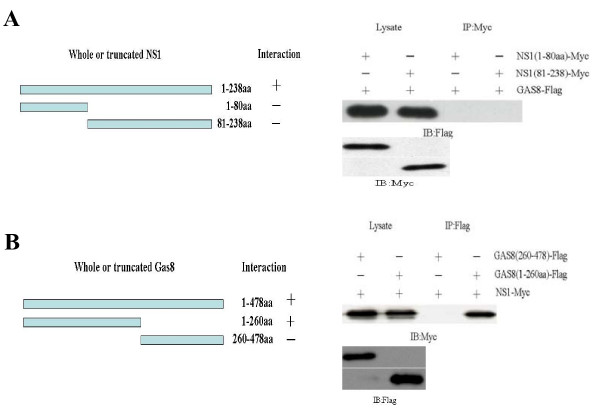
Protein-protein interaction domains. (A) Mapping of the NS1 domain interacting with Gas8. 293FT cells were transfected with pCMV-Tag 2B-Gas8 and one of its truncated derivatives: pCMV-myc-NS11-80, pCMV-myc-NS181-238, or pCMV-myc. After incubation for 36 h, cell lysates were IPed with anti-myc antibody and probed with anti-FLAG and anti-myc antibody. (B) Schematic representation of Gas8 proteins. Polypeptides corresponding to Gas81-478, Gas81-260, and Gas8260-478 are shown. The corresponding amino acids are indicated on the right. 293FT cells were transfected with pCMV-myc-NS1 and one of its truncated derivatives: pCMV-Tag 2B-Gas81-260, pCMV-Tag 2B-Gas8260-478, or pCMV-Tag 2B. Cell lysates were IPed with anti-myc antibody and probed with anti-FLAG and anti-myc antibody. +: protein-protein interaction; -: no protein-protein interaction.